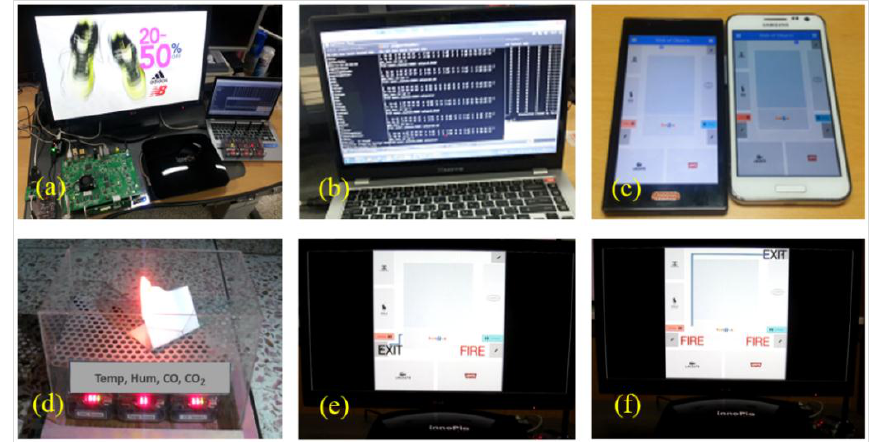
Figure 27. Demonstration of the use case scenario on a WoO service platform, which includes ( a ) smart gateway and sensors; ( b ) Application Server; ( c ) user interface; ( d ) fire occurrence and ( e , f )